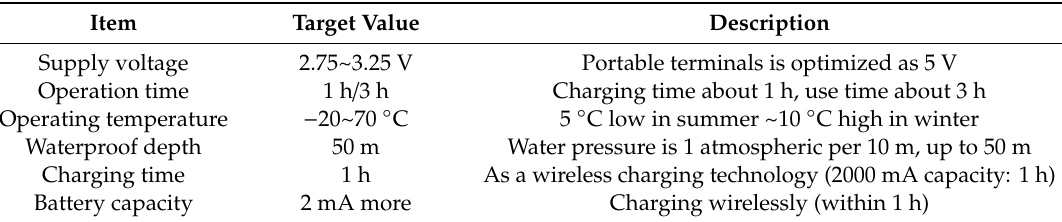
Table 1. Target values of DiverPAD.